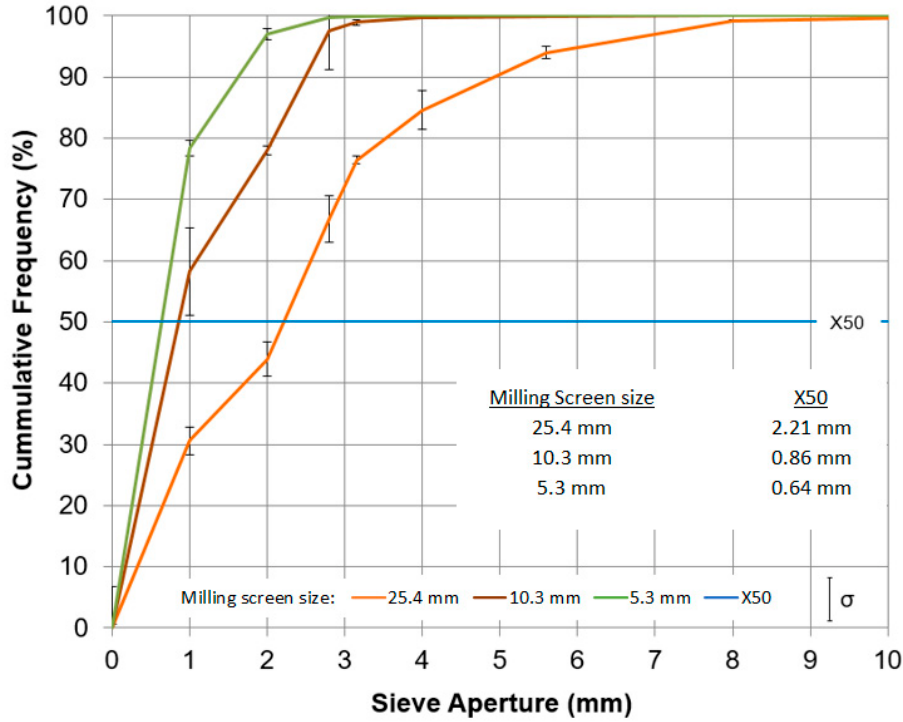
Figure 3. Particle size distribution and mean particle size (X50) for poplar wood milled in a hammer mill at three different screen sizes.